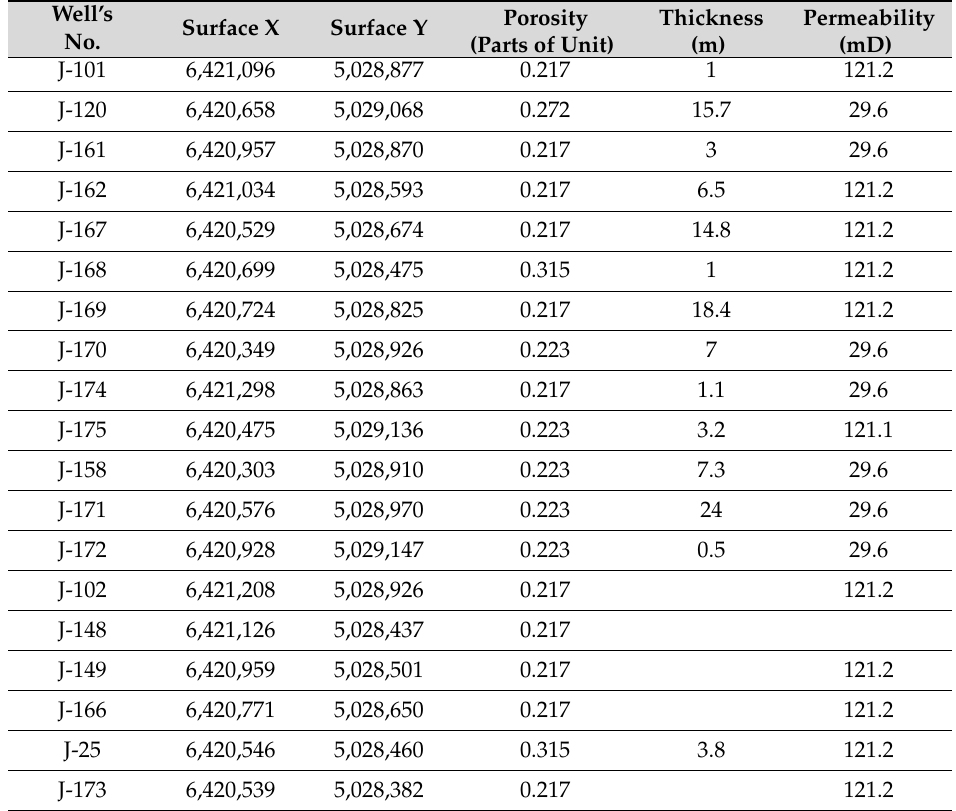
Table 2. Raw data of porosity, permeability and thickness data interpolated in the “K” reservoir (coordinates are in a Gauss–Krueger